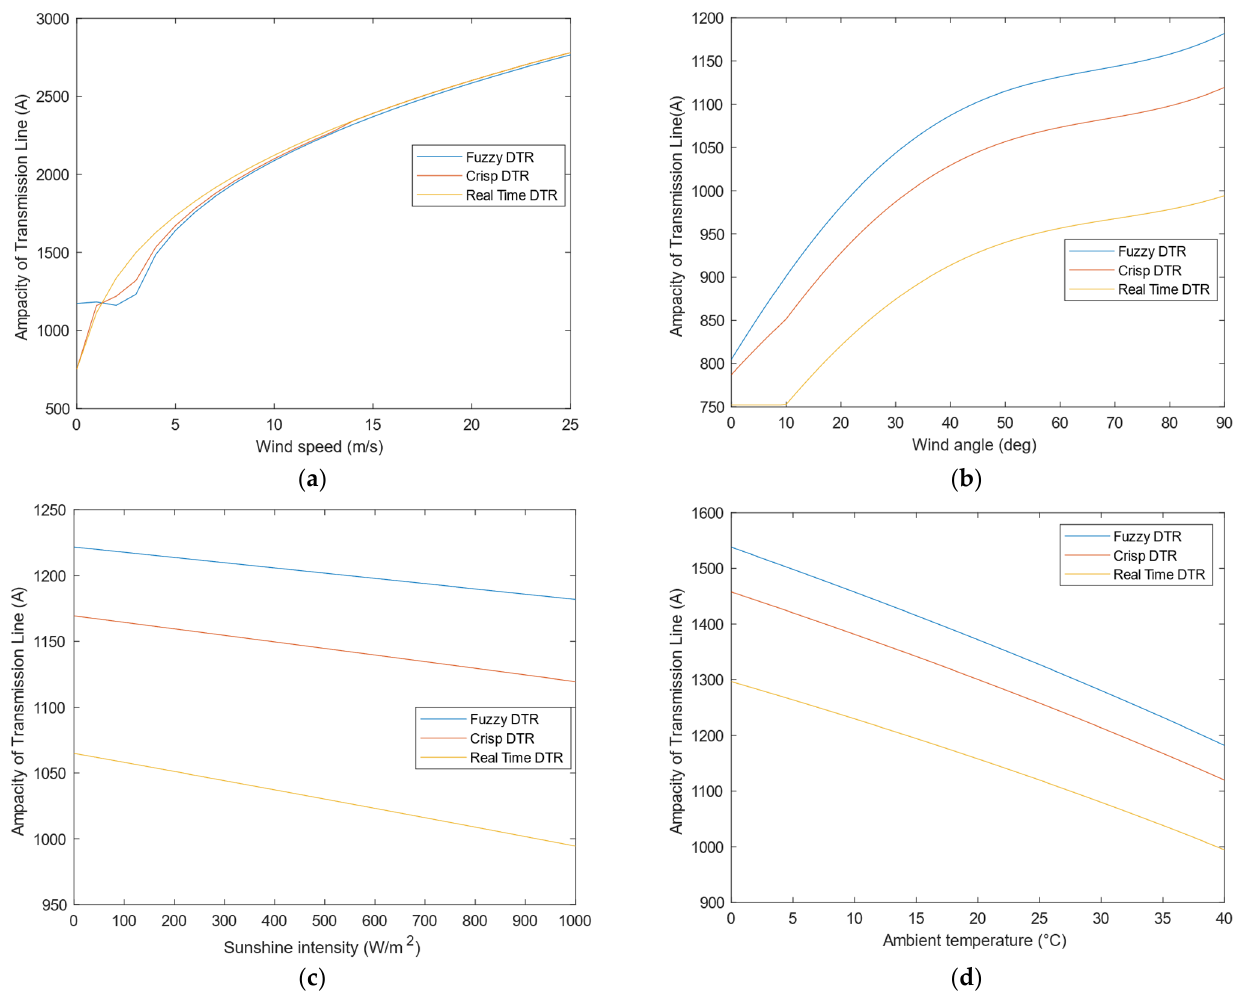
Figure 4. ( a ) Impact of wind speed on the transmission line’s capacity; ( b ) impact of wind angle on the transmission line’s capacity; ( c ) impact of wind solar intensity on the transmission line’s capacity; ( d ) impact of ambient temperature on the transmission line’s capacity.